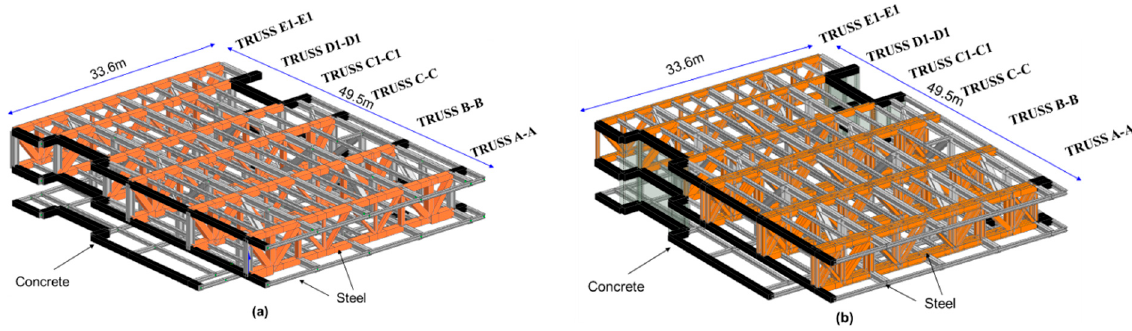
Figure 3. Overall view of the steel trusses. ( a ) Original design scheme; ( b ) Optimal design scheme.